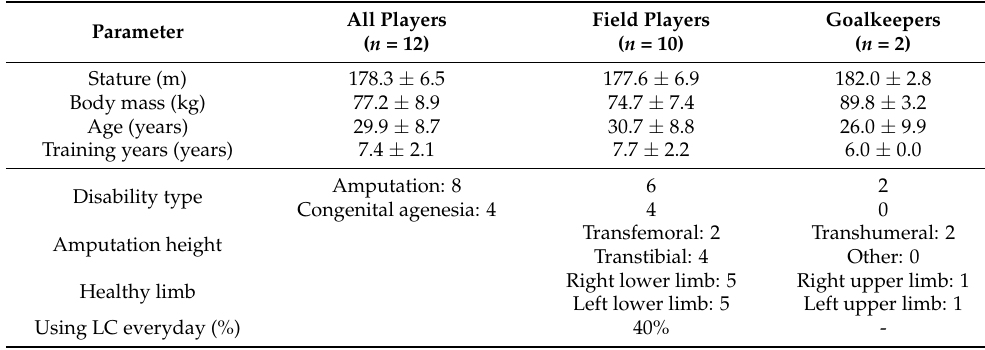
Table 1. Group characteristics.